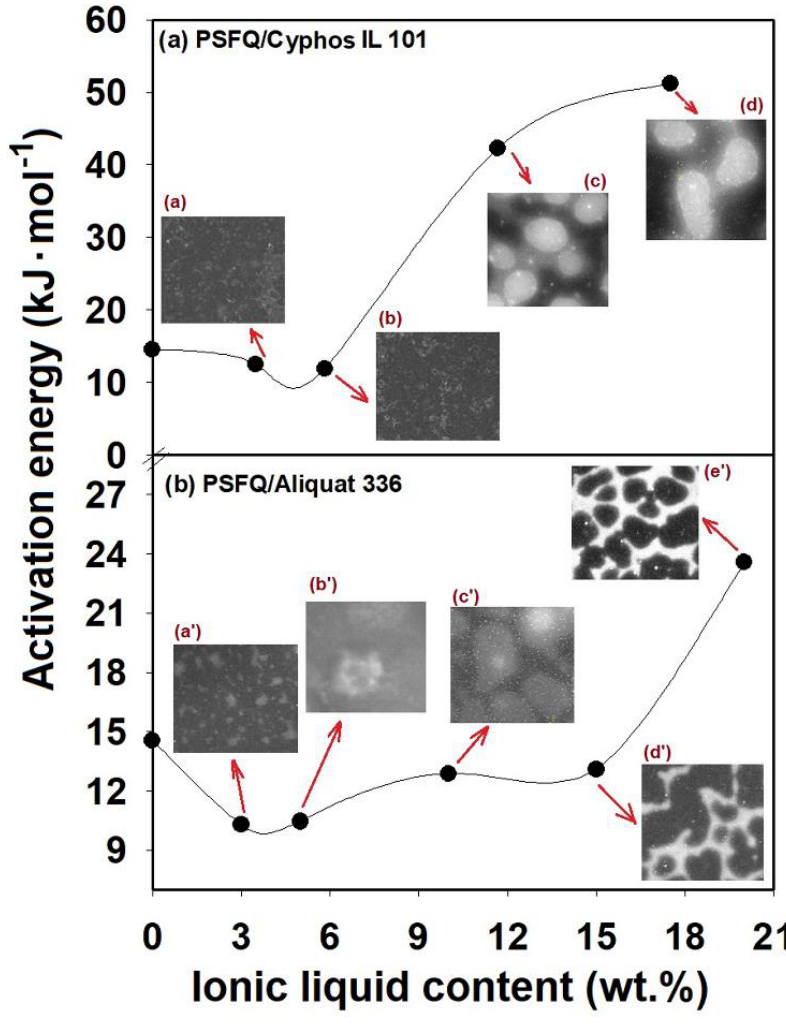
Figure 5. Activation energy as a function of IL composition for ( a ) PSFQ/Cyphos IL 101 and ( b ) PSFQ/Aliquat 336 systems. Small images represent STEM images recorded for different IL compositions in studied systems: (a) 3 wt%, (b) 5 wt%, (c) 10 wt% and (d) 15 wt% for PSFQ/Cyphos IL 101 system, and (a’) 3 wt%, (b’) 5 wt%, (c’) 10 wt%, (d’) 15 wt% and (e’) 20 wt% for PSFQ/Aliquat 336 system.